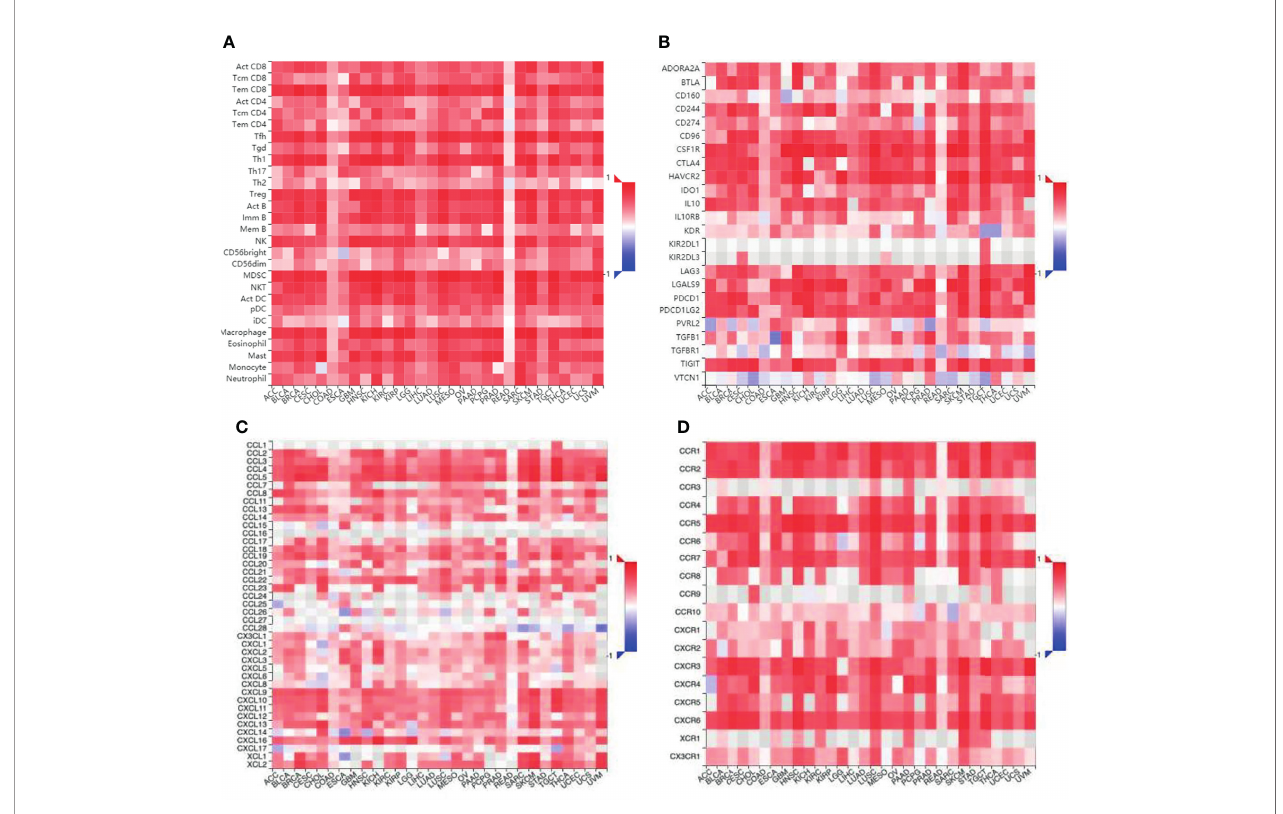
FIGURE 4 | The relationship between different immune cells and immunomodulators and the expression of TNFR2 in various cancers. (A) Bioinformatics analysis of the correlation of TNFR2 expression and immune cell numbers. (B) The relationship between TNFR2 expression and immune inhibitors. (C, D) The correlation between TNFR2 and the expression of chemokines and their receptors. All data were obtained from the TCGA database through